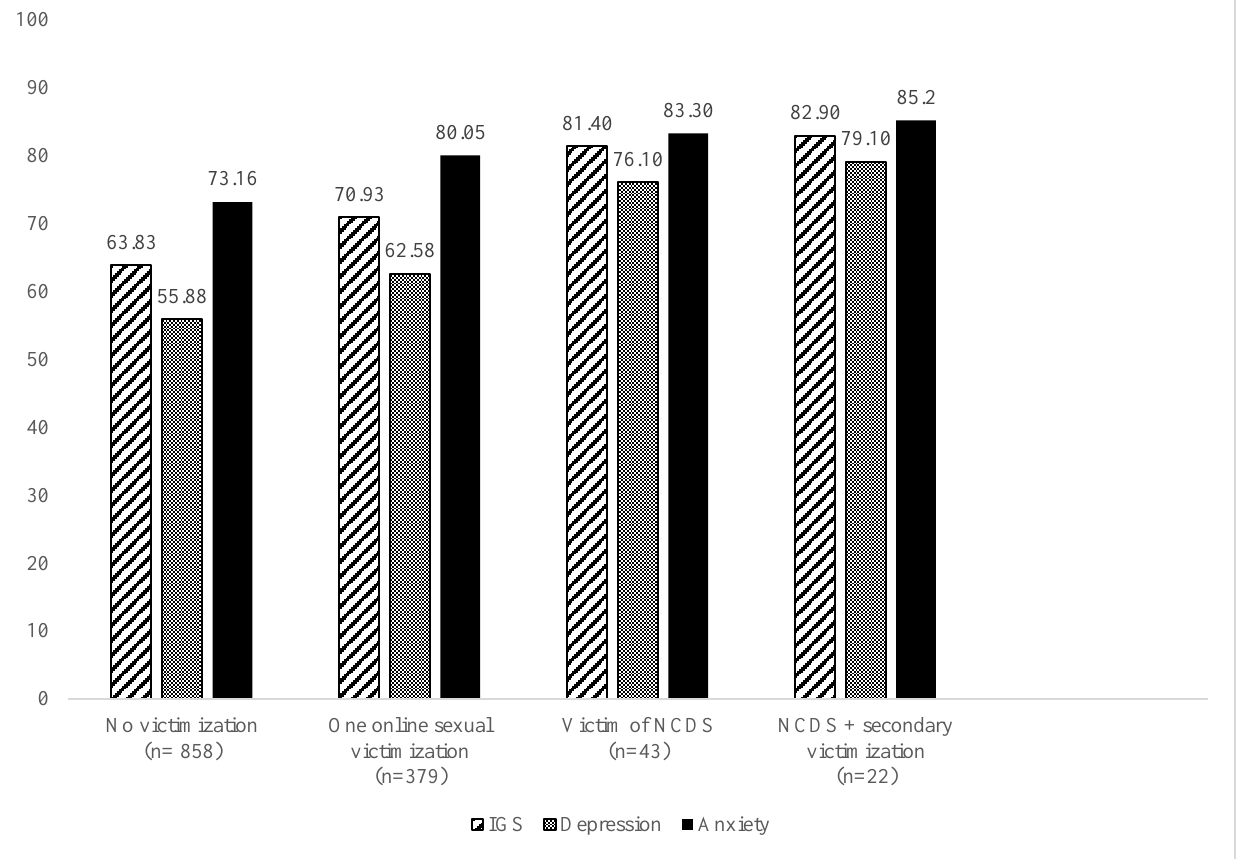
Figure 1. Means for psychopathology scores and levels of victimization. Note: NCDS = non-consensual dissemination of sexting.